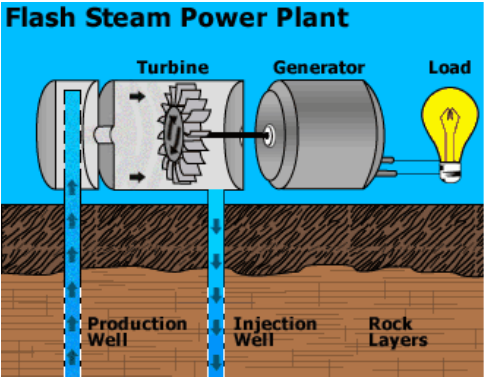
Figure 5. Flash steam power plant for the power generation [33].